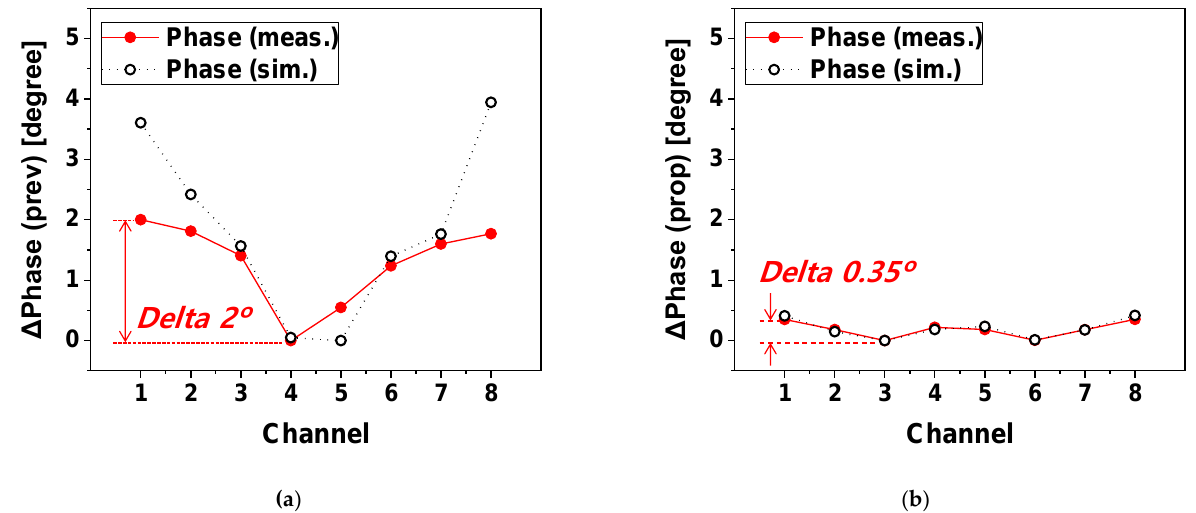
Figure 8. Simulation and measurement results of the phase difference between channels: ( a ) in the previous module, ( b ) in the proposed module.